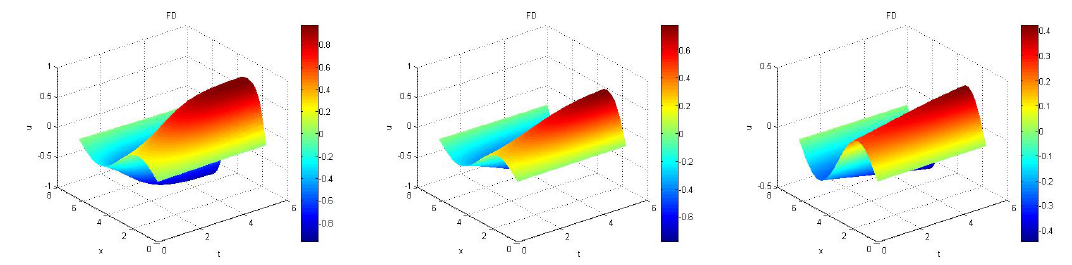
Figure 5. [Test 2] Solution of the full discretized system with (cid:101) = 0.2,0.5,0.8 (from left to